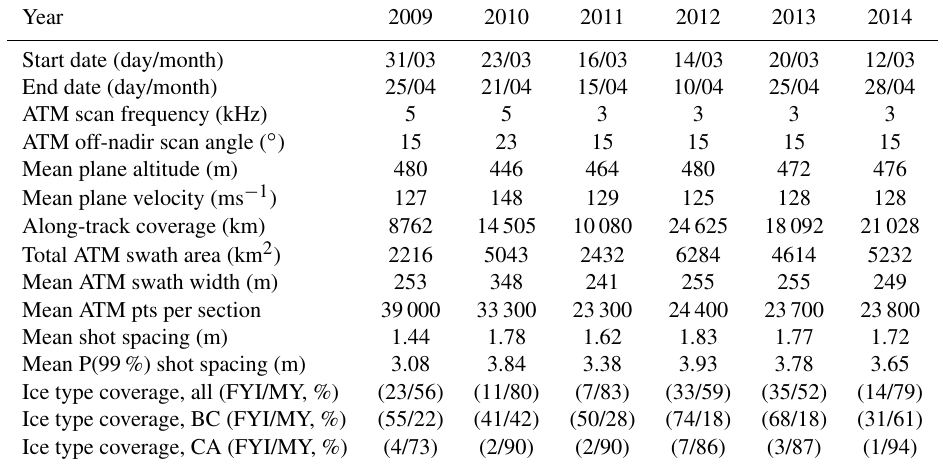
Table 1. IceBridge ATM flight information. Note that all calculated quantities (rows 3–13) are based on the permissible sea ice sections, as described in Sect. 3. The ice type classification is also described in more detail in Sect. 3 (rows